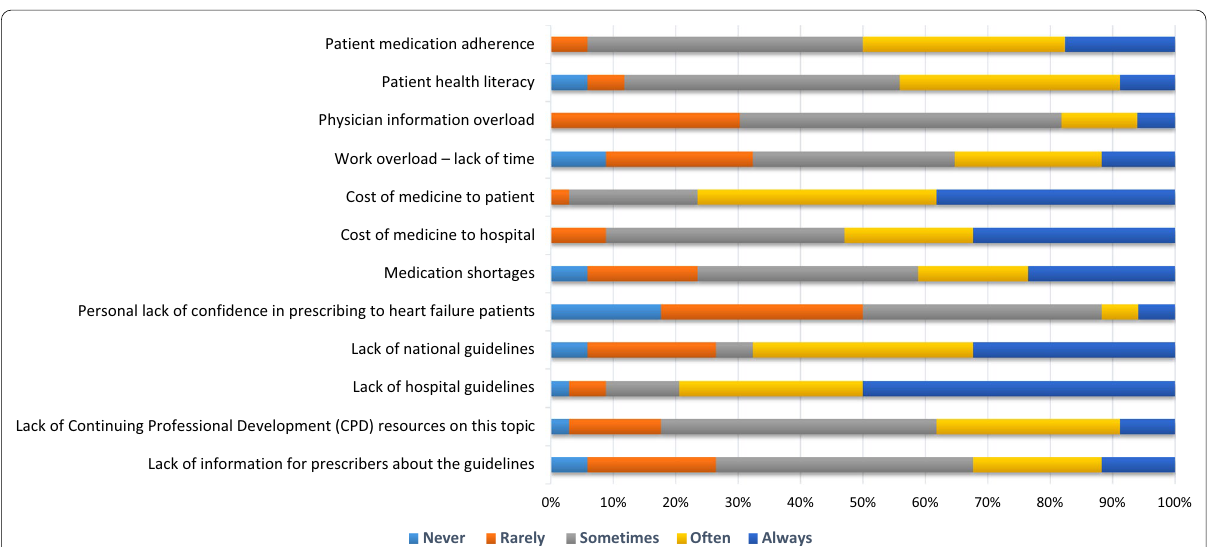
Fig. 3 Barriers to prescribing the guideline-directed therapies from the perspective of respondents. Survey question: To what extent do you agree or disagree that each of the following is a barrier/obstacle to prescribing guideline-directed therapies in your patients? Please use the scale from ‘ Never ’ up to ‘ Always ’. Data are presented for the total